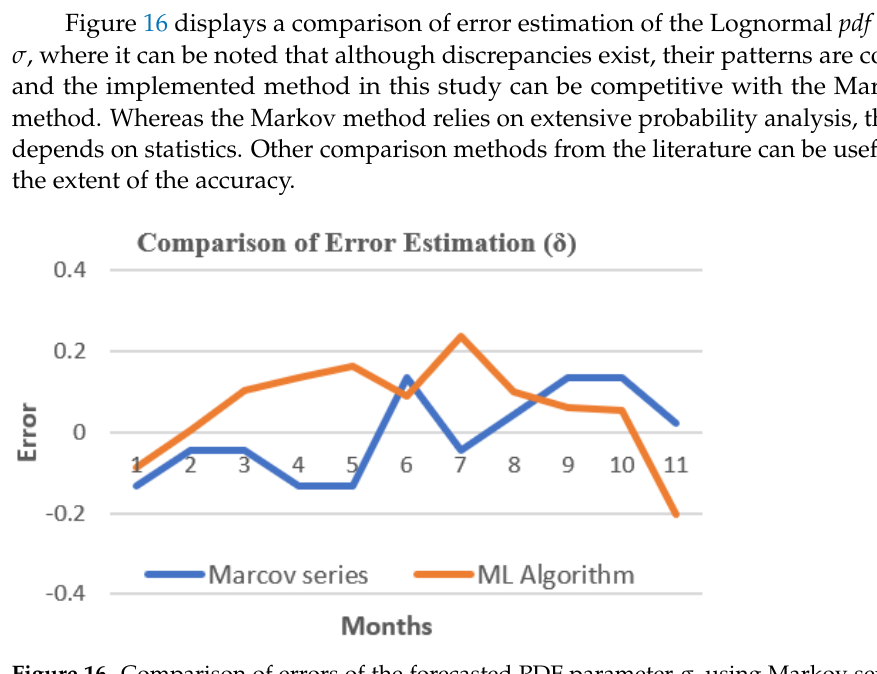
Figure 16. Comparison of errors of the forecasted PDF parameter σ, using Markov series and the implemented algorithm.